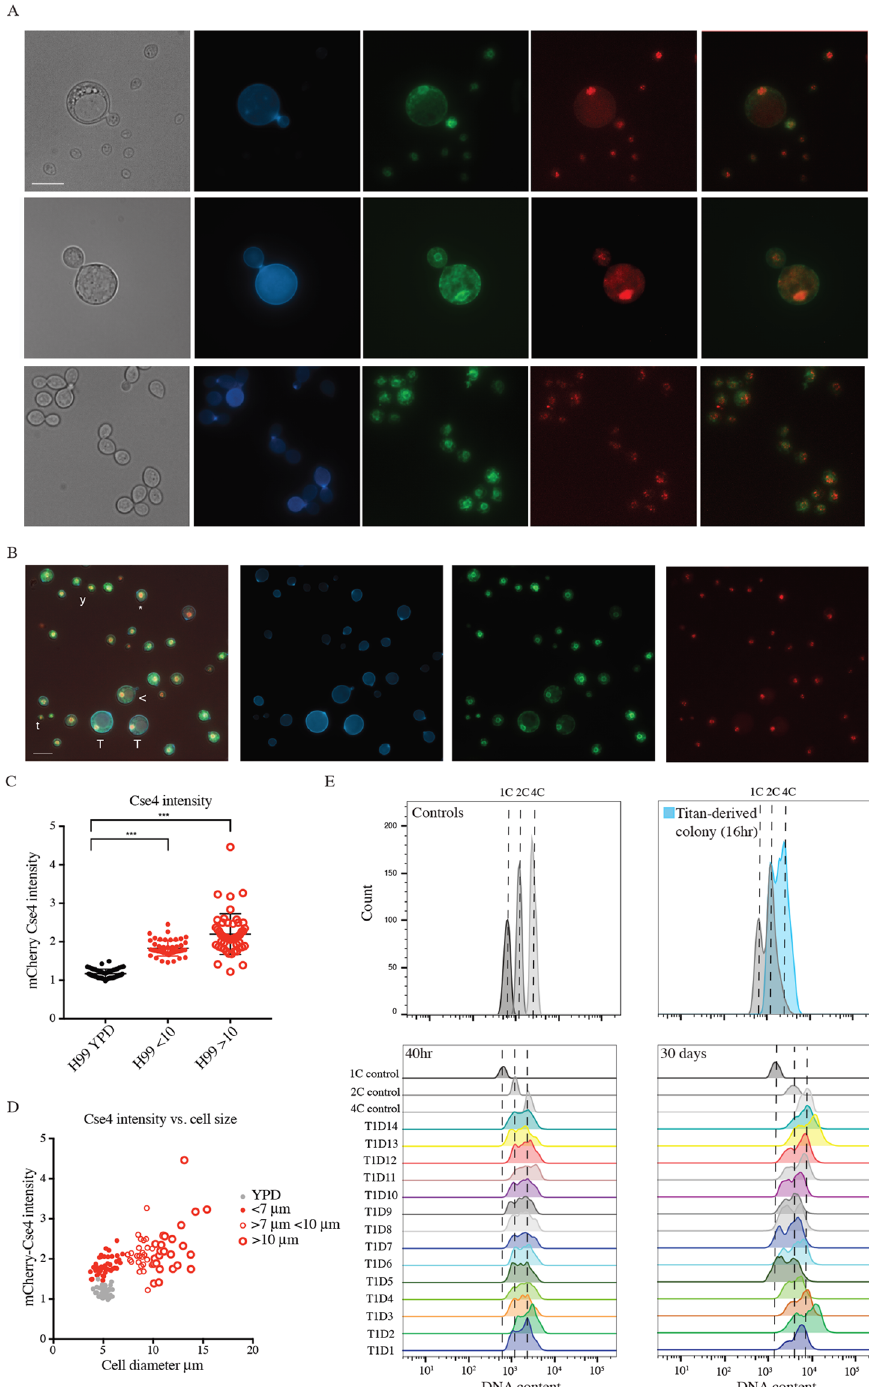
Fig 3. Daughter cells from in vitro Titans have altered ploidy relative to the haploid parent. A) Representative budding Titan cells (top panels) and yeast cells (bottom panel). CNV111 haploid cells encoding GFP-Ndc1 (membrane) and mCherry-Cse4 (kinetochore) were induced (top) or grown in YPD (bottom) and stained for chitin (CFW, 10 μg/ml). Scale bar = 10 μm. B) Induced CNV111 cells showing population heterogeneity (T,Titan; Y,Yeast; t, Titanide; ( (cid:3) ), aneuploid; ( < ), less than 10 μm). Scale bar = 10 μm. C,D) CNV111 cells were quantified for mCherry- Cse4 foci and mother cell size (YPD n = 50, induced n = 100). E) Daughters arising from a single Titan mother were isolated and allowed to proliferate for 72 hr at 30˚C on YPD agar prior to fixation and staining for DNA